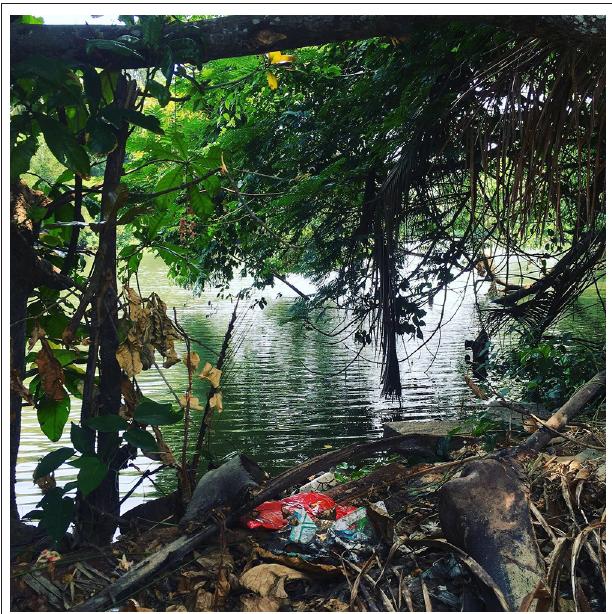
FIGURE 7 | This area became part of the site for collection along the Karamana River. While brush and debris exists along the water’s edge, the ground is solid and the approach is flat (Photo by K.